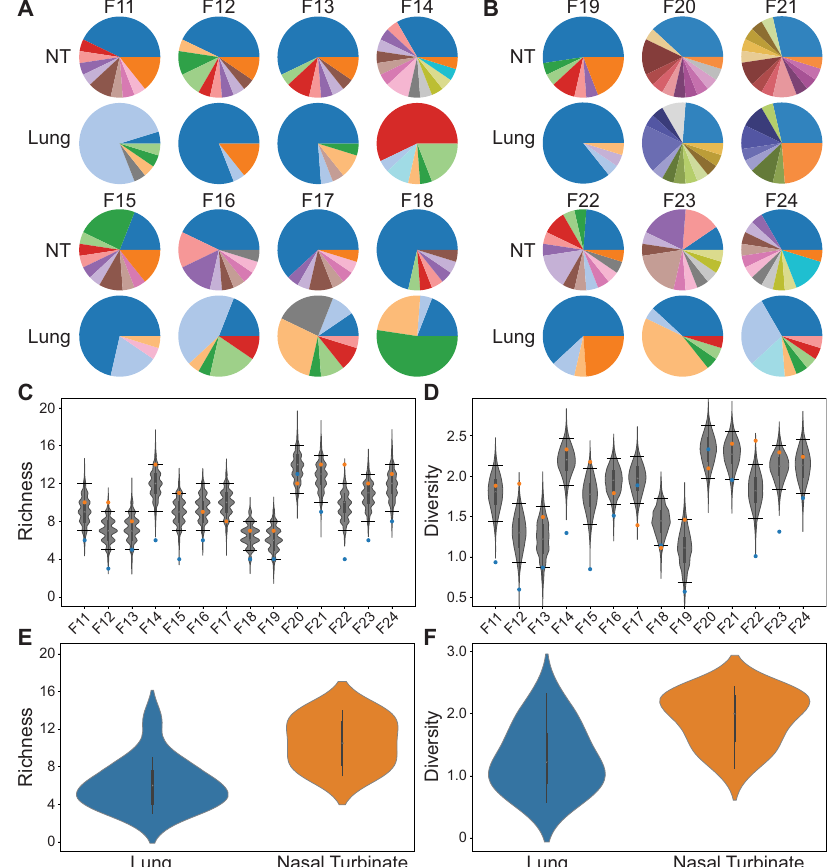
Fig. 2 | Viral diversity generated through reassortment is greater in the ferret nasal turbinates than in the lungs. Pie charts show frequencies of unique geno- types detected in the nasal turbinates (NT) and lung of ferrets inoculated with 1×10 2 FID 50 ( A ) or 1×10 5 FID 50 ( B ). Ferrets shown were analyzed at the following timespost-infection:Day1(F11,12,19,20),Day2(F13,14,21,22),Day3(F15,16,23), andDay4(F17,18,24).BlueandorangesectionsofthepiechartsrepresentVARand WT parental genotypes, respectively. Richness ( C ) and diversity ( D ) are plotted, with observed results (colored points) overlaid on the distribution of simulated data (gray violins) ( n =1000 simulations per ferret). Horizontal lines denote the